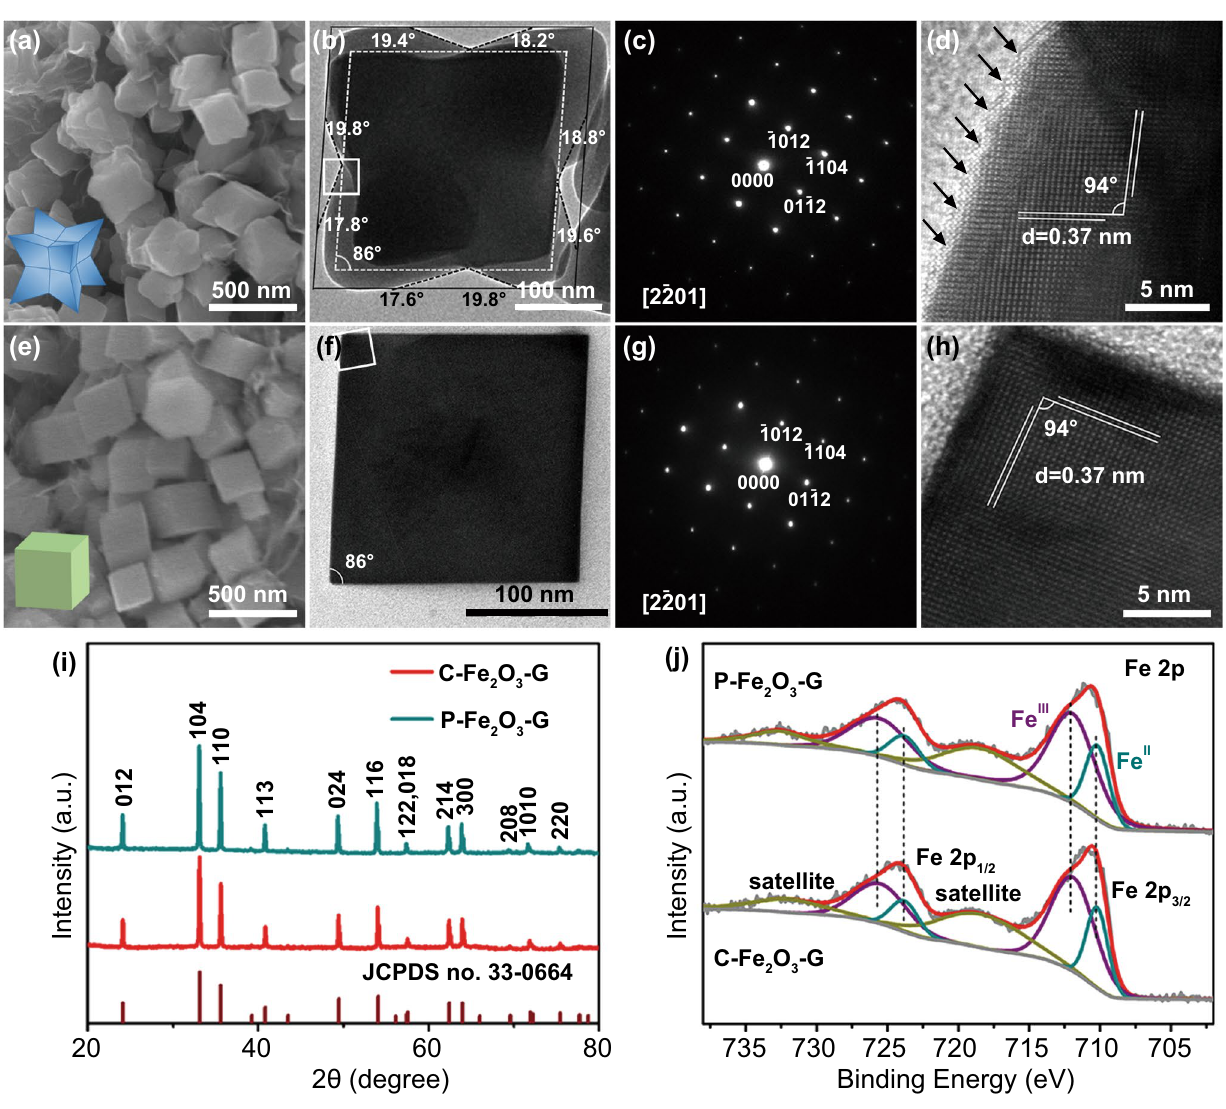
Fig. 1 a SEM image, b TEM image, c corresponding SAED pattern and d HRTEM image of C-Fe 2 O 3 -G. e SEM image, f TEM image, g cor- responding SAED pattern and h HRTEM image of P-Fe 2 O 3 -G. i XRD patterns and j Fe 2p XPS spectrums of C-Fe 2 O 3 -G and P-Fe 2 O 3 -G. The insets in a and e are the schematic models of C-Fe 2 O 3 and P-Fe 2 O 3 ,